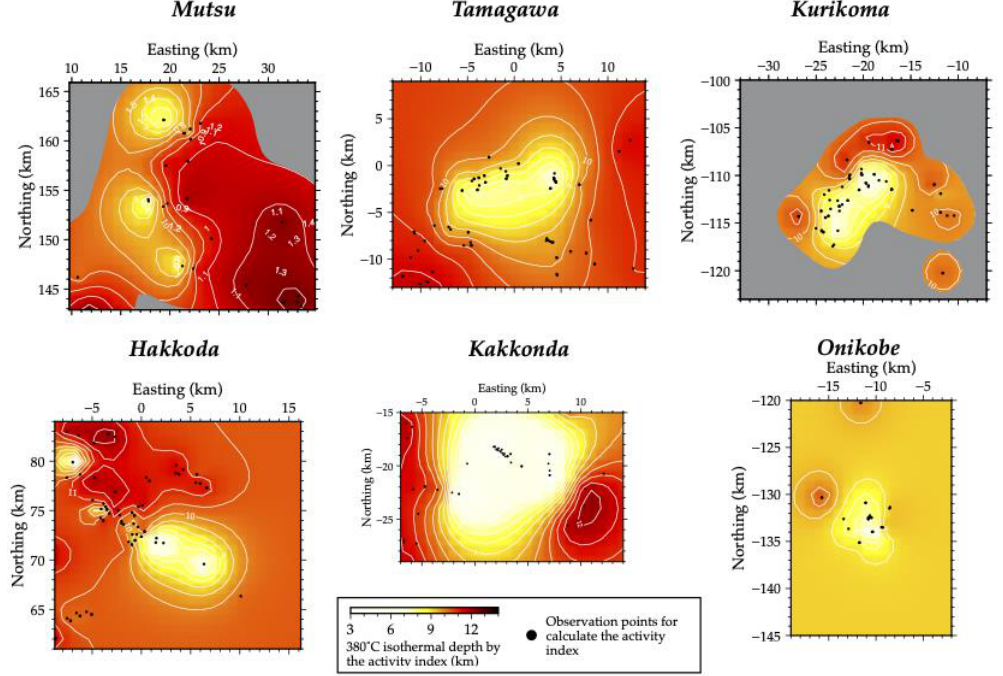
Figure 11. The depth distribution maps corresponding to 380 °C estimated from the activity index in each geothermal field. The black dots indicate the location of the data points used to calculate the activity index.